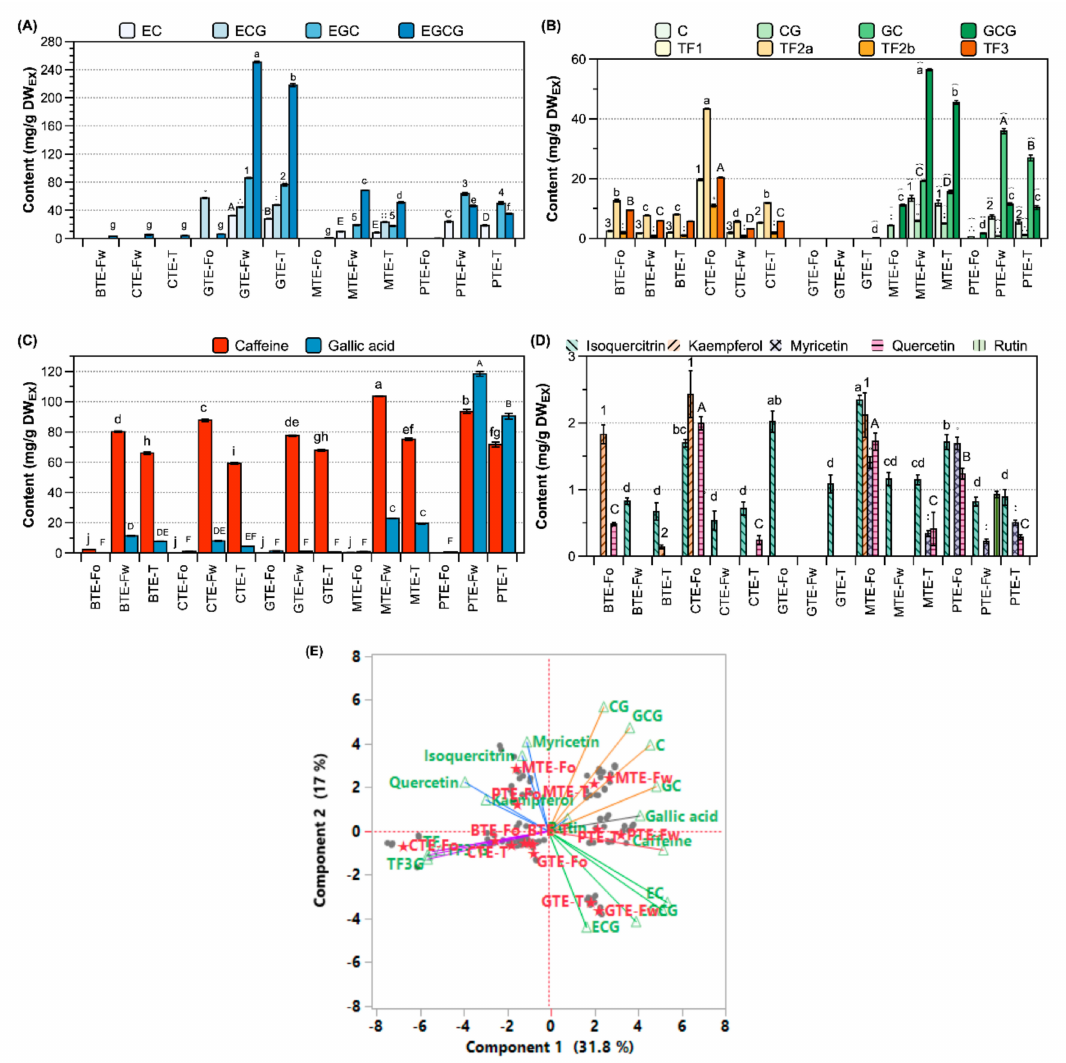
Figure 2. Contents of phenolic compounds and ca ff eine in the five tea extracts and their fractions. ( A ) Epicatechins, ( B ) theaflavins and non-epicatechins, ( C ) ca ff eine and gallic acid, ( D ) flavonol glycosides, and ( E ) Correlation between 20 identified compounds and the extracts and fractions by PCA. Di ff erent letters, numbers, and dotted marks on the bars indicate significant di ff erences according to the Tukey–Kramer honestly significant di ff erence test ( p < 0.05). The su ffi xes -T, -Fw, and -Fo on the X-axis indicate whole extract, hydrophilic fraction (W FR ), and hydrophobic fraction (O FR ), respectively. DW EX , dry weight of extract; EC, ( − )-epicatechin; ECG, ( − )-epicatechin gallate; EGC, ( − )-epigallocatechin; EGCG, ( − )-epigallocatechin gallate; C, ( − )-catechin; CG, ( − )-catechin gallate; GC, ( − )-gallocatechin; GCG, ( − )-gallocatechin gallate; TF1, theaflavin; TF2a, theaflavin 3- O -gallate; TF2b, theaflavin-3 (cid:48) - O -gallate; and TF3, theaflavin-3,3 (cid:48) - O